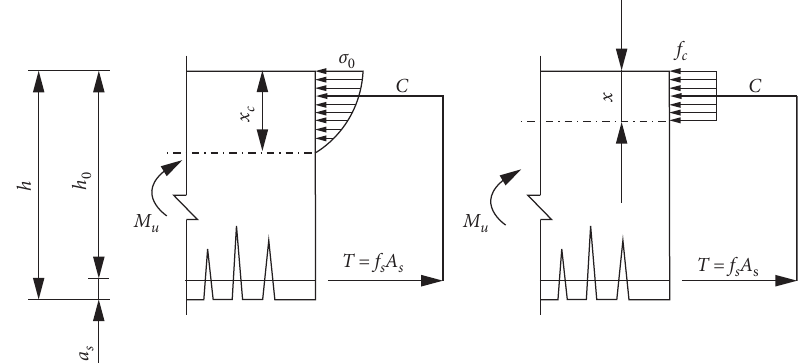
Figure 20: Distribution of bending stress on the cross section. Table 6: Comparison of experimental and calculated ultimate flexural capacity.